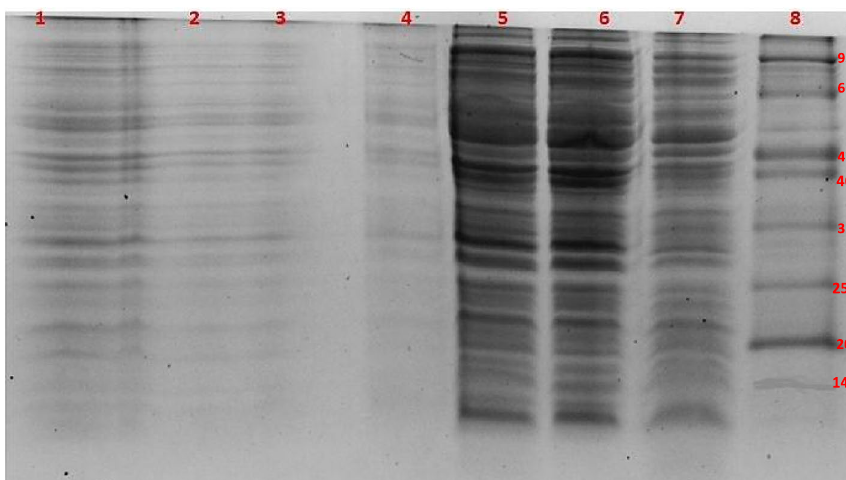
Fig. 10 Tricine SDS-PAGE analysis of the E. coli cells with pET-32a- Pp -ALF before and after IPTG induction on a time-course basis. Lane 1: Uninduced control (before IPTG induction). Lane 2–7 IPTG-induced cells after 0–6h of induction lane 8: Mid-range protein